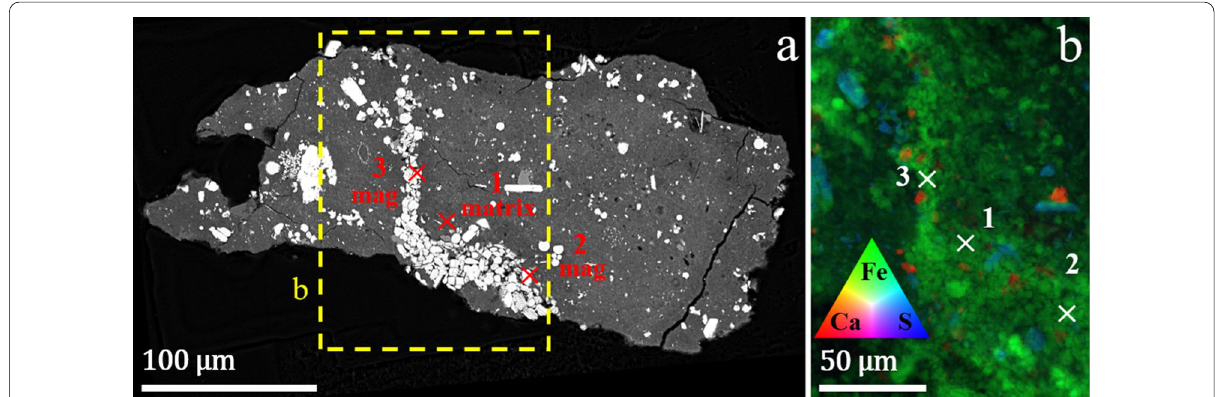
Fig. 2 a BSE image of C0033‑01 after epoxy fixation. The magnetite vein is highlighted in yellow. b High‑resolution SR‑XRF overview scan (200 nm step size) of the magnetite region presented in a . Unlike the BSE image that includes only surface information, the SR‑XRF image includes additional